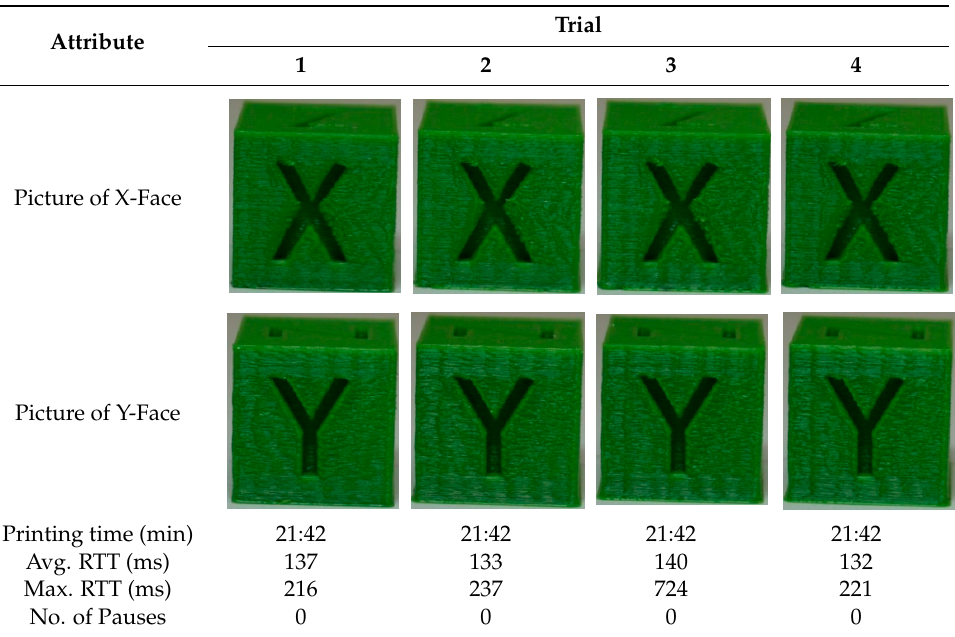
Table 7. Attributes of the Calibration Cube printed using a cloud-based controller stationed in Sydney, Australia.